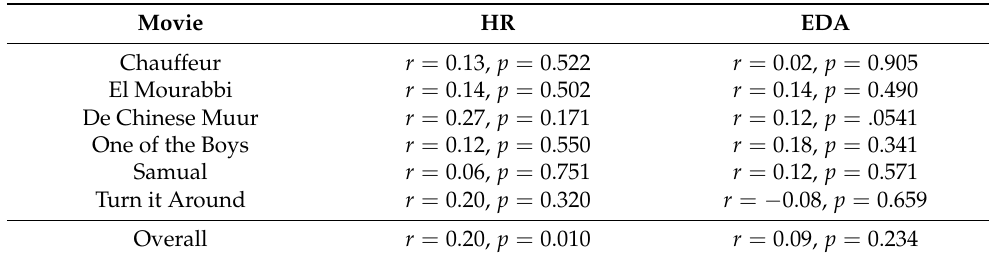
Table 2. Spearman correlations between number of correct answers on questions about the content of the movie and participant-to-group physiological